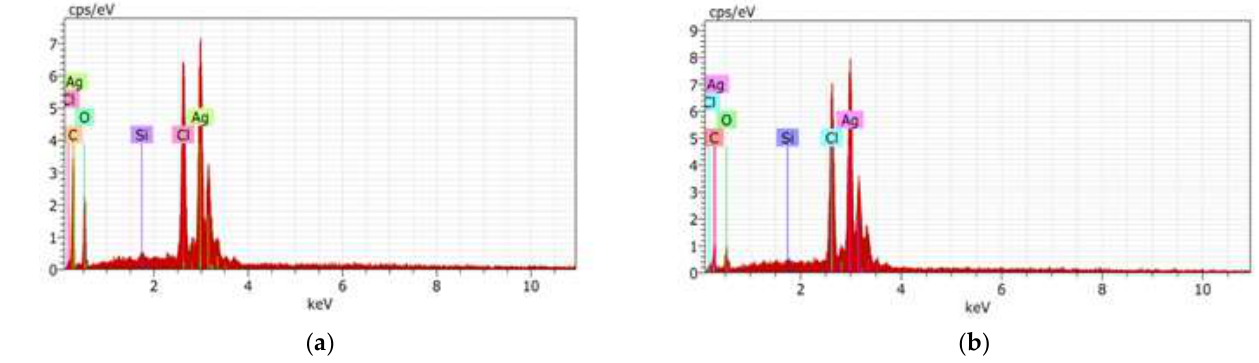
Figure 5. EDS spectra of ( a ) AgNPs-FCg and ( b ) AgNPs-LCg at several concentrations of AgNO 3 .